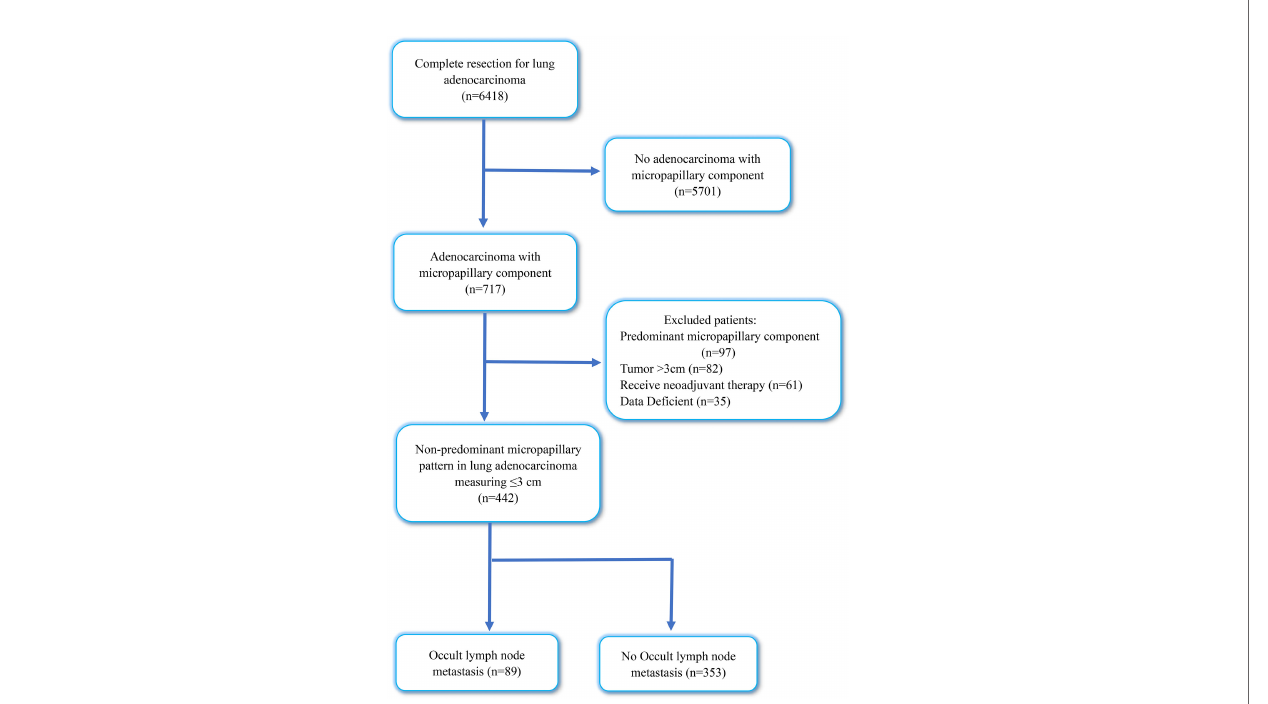
FIGURE 1 | Flow diagram of patients excluded in this research. OLNM, occult lymph node metastasis; NOLNM, non- occult lymph node